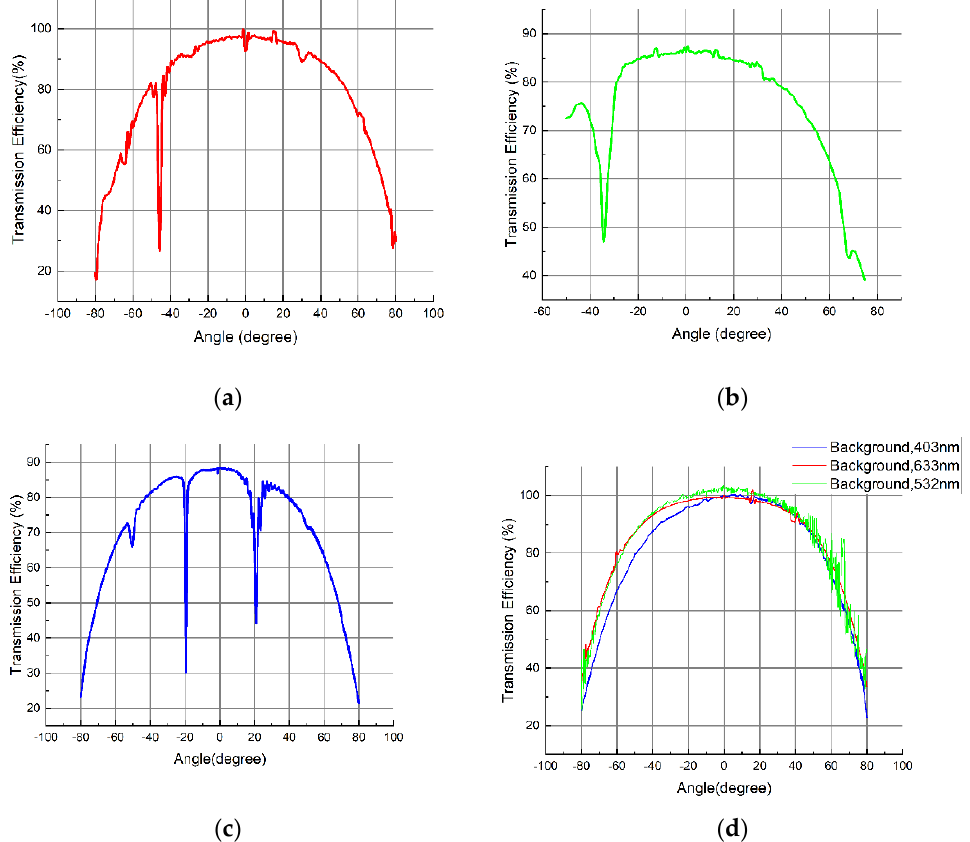
Figure 10. Transmission efficiency versus angle of incidence for the HOE coupler when probed with wavelengths of ( a ) 633 nm, ( b ) 532 nm and ( c ) 403 nm ( d ). Background measurements made for the same range of angles at all three wavelengths with a glass slide in place of the HOE.